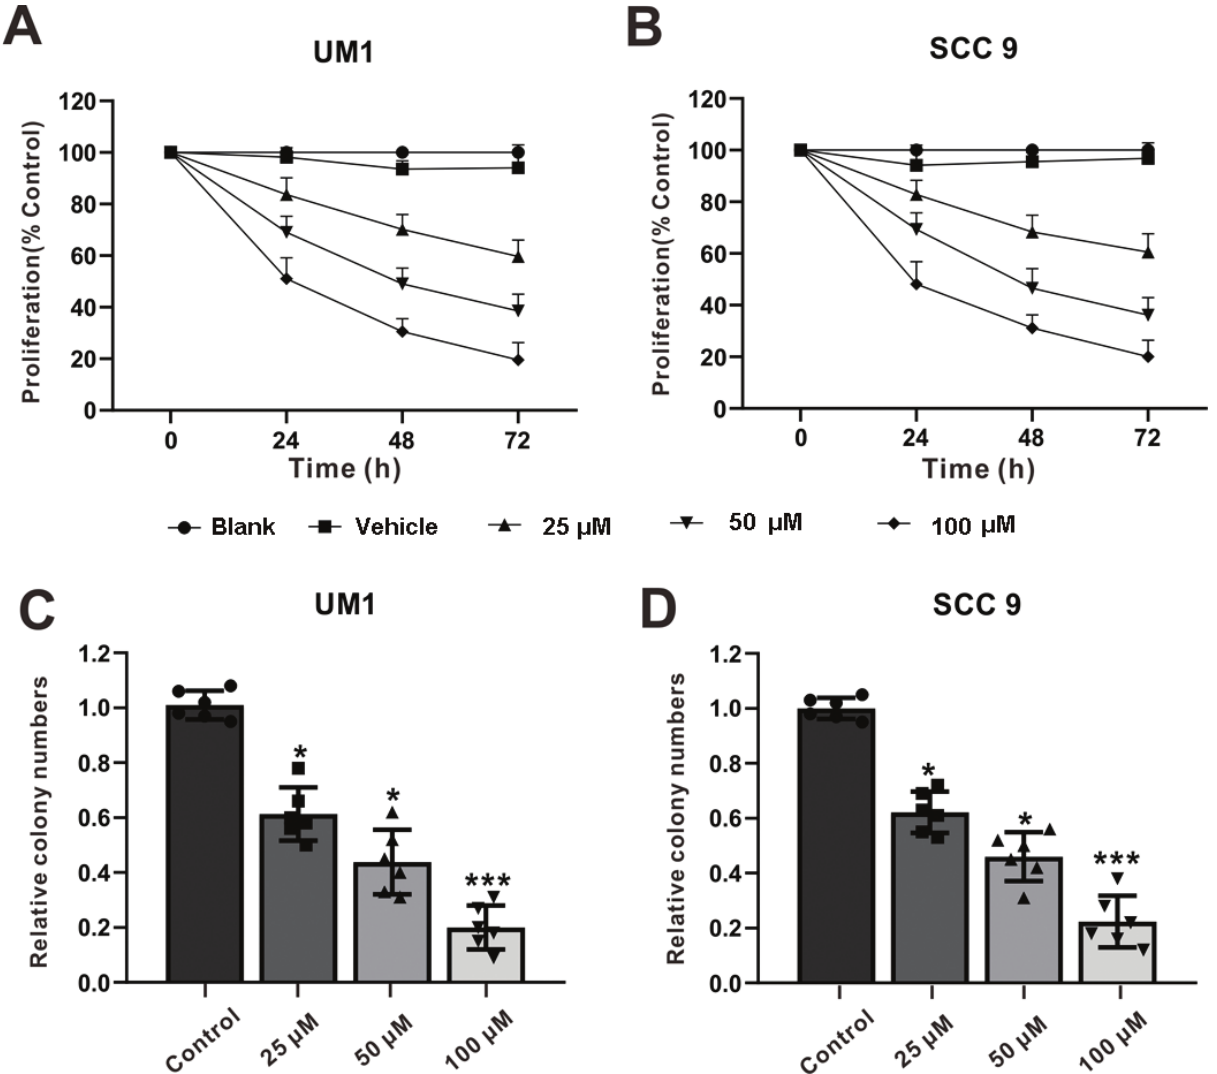
Fig. 1. Geraniol inhibits proliferation and colony formation of UM1 and SCC 9 cells in a time- and dose-dependent manner. (A and B) Cells were treated with vehicle or different concentrations of geraniol as indicated. Cell viability was determined by Cell Counting Kit-8 (CCK-8) assay at 24, 48, and 72 h following treatment. (C–D) Colony formation assay was performed to evaluate the colony formation ability of cells with vehicle or different concentrations of geraniol as indicated. * P < 0.05 and *** P < 0.001, compared with the control group.